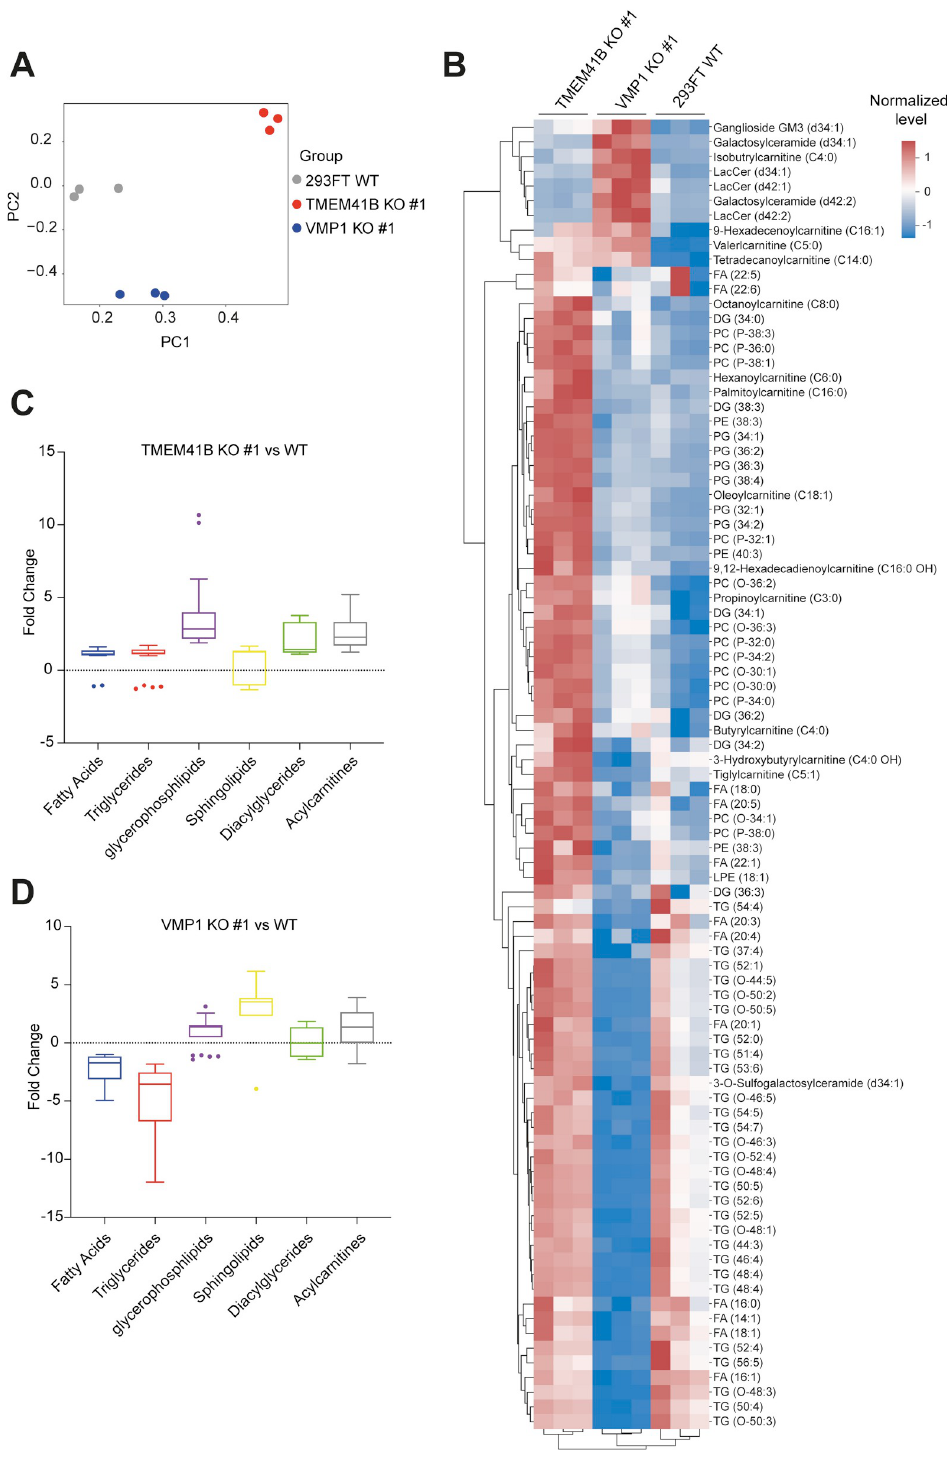
Fig 5. TMEM41B and VMP1 deficiency impose a diverse and distinctive impact on cellular metabolism in 293FT. (A) Principal Components Analysis (PCA) for the metabolomic datasets of 293FT WT, TMEM41B clone #1, and VMP1 KO clone #1 cells. First two principal components are demonstrated on the x- and y-axis. (B) Heatmap of altered metabolites in the 293FT WT and KO clones. Z-score normalized values of metabolite levels were used to plot the heatmap (see Materials and Methods). Color scheme depicts the relative abundance of metabolites with red and